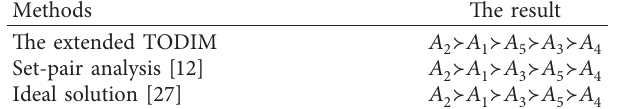
Table 5: The comparison results. Methods